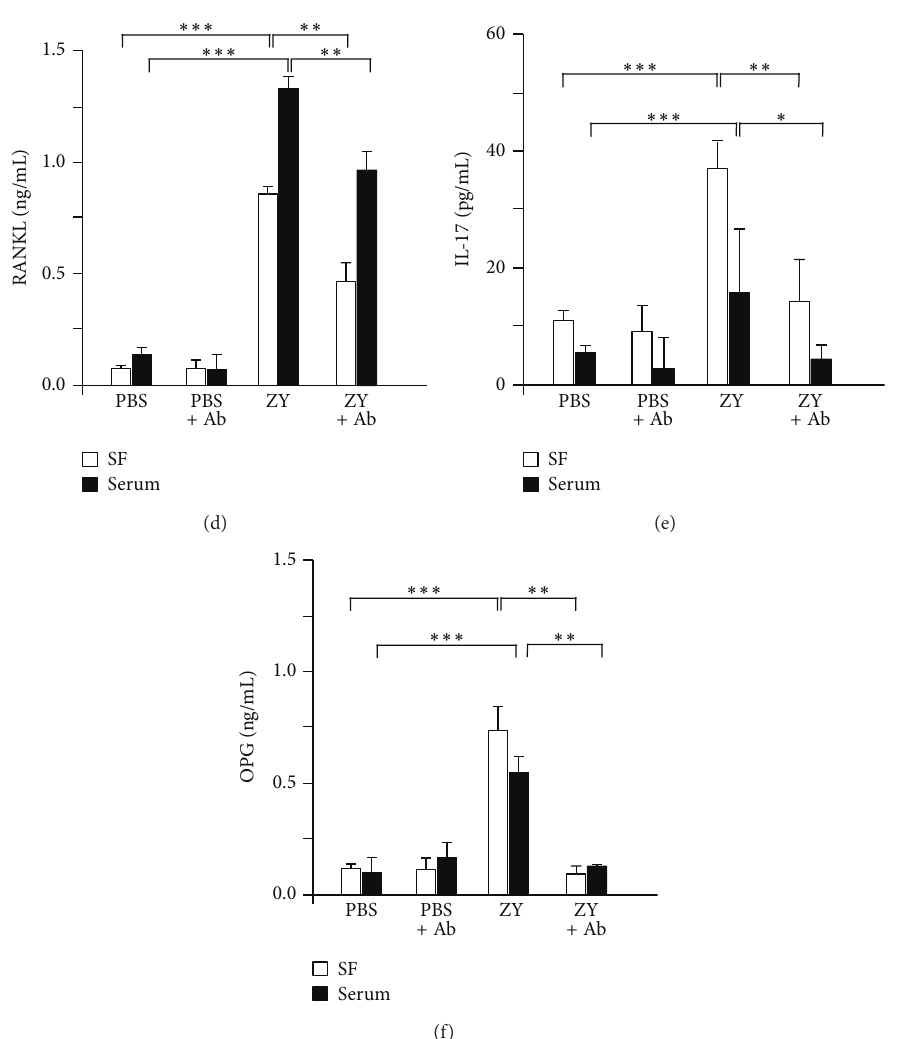
Figure 2: Depletion of Ly6G + CD11b + cells with monoclonal 1A8 antibody (Ab). (a) SCID mice were injected intraperitoneally (i.p) with 1A8 Ab (100 𝜇 g/mouse) at days − 2, +2, and +4 (arrows showing the injections). The mice received intra-articular (i.a.) knee injection of PBS (10 𝜇 L; naive) or zymosan (200 𝜇 g/10 𝜇 L; arrow ZY) at day 0. Flow cytometry analysis indicates the loss of Ly6G + CD11b + cells in BM after Ab treatments. Values are the mean ± SEM ( 𝑛 = 7 mice/group), Student’s 𝑡 -test. (b) At day 7 of TLR2 ligand injection (or 3 days after the last 1A8 Ab administration) Ly6G + CD11b + cells partially recover in BM but are completely lost in blood and SF of 1A8 Ab-treated mice. Bars indicate the mean ± SEM ( 𝑛 = 7 mice/group). ∗ 𝑃 < 0.05 ; ∗∗ 𝑃 < 0.01 ; ∗∗∗ 𝑃 < 0.001 , Student’s 𝑡 -test. (c) The administration of 1A8 Ab attenuates joint damages as shown on the representative photomicrographs (magnification 100x) and by histological scores for cell infiltration (I), proteoglycan (PG) loss, and percentages of cartilage erosion. Values are the mean ± SEM ( 𝑛 = 7 mice/group). ∗∗ 𝑃 < 0.01 ; ∗∗∗ 𝑃 < 0.001 , Kruskal-Wallis test and Mann-Whitney U -test. Ly6G + cell depletion decreases the amounts of RANKL (d), IL-17 (e), and OPG (f) in serum and SF of ZY mice. Values in (d), (e), and (f) are the mean ± SEM ( 𝑛 = 7 animals/group). ∗ 𝑃 < 0.05 ; ∗∗ 𝑃 < 0.01 ; ∗∗∗ 𝑃 < 0.001 , Student’s 𝑡